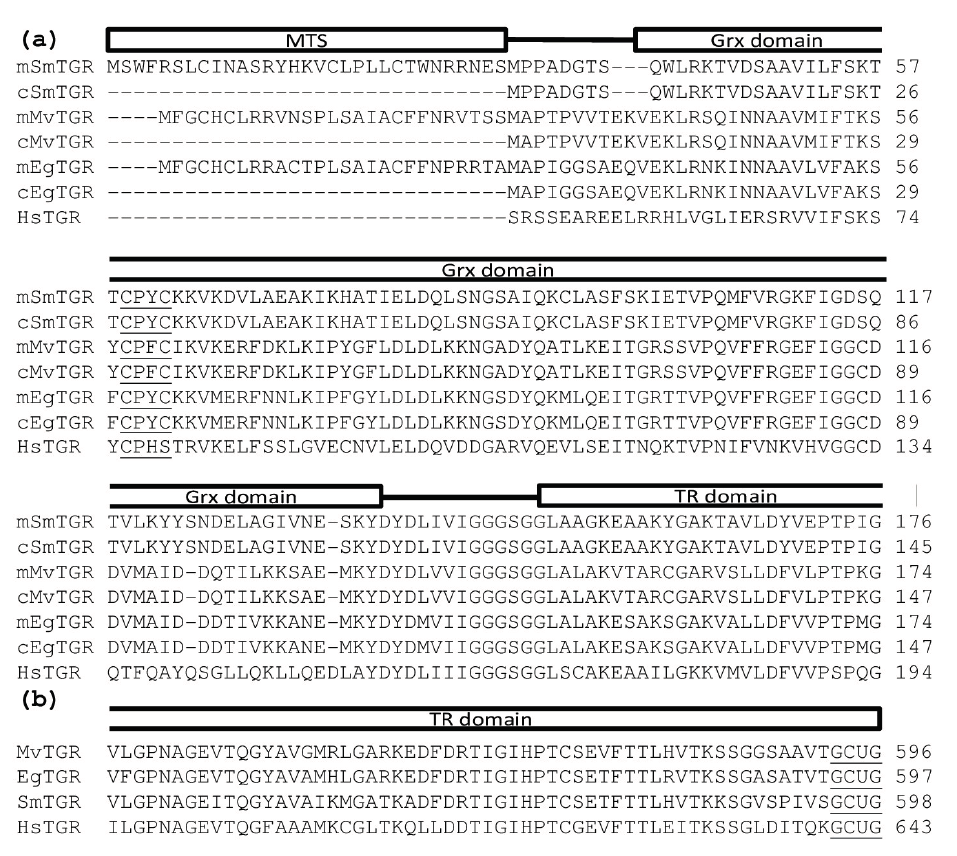
Figure 2. Protein sequence alignment of human and flatworm TGRs. Partial sequences from M. vogae (Mv), S. mansoni (Sm, AAK85233.1), E. granulosus (Eg, AAN63052.1) and H. sapiens (Hs, NP_443115.1) TGRs are aligned and N-terminus and C-terminus of the proteins are shown in ( a , b ), respectively. Conserved domains and mitochondrial targeting (m and c) for flatworm TGRs are shown. Grx domain active site and selenocysteine-containing TR domain are